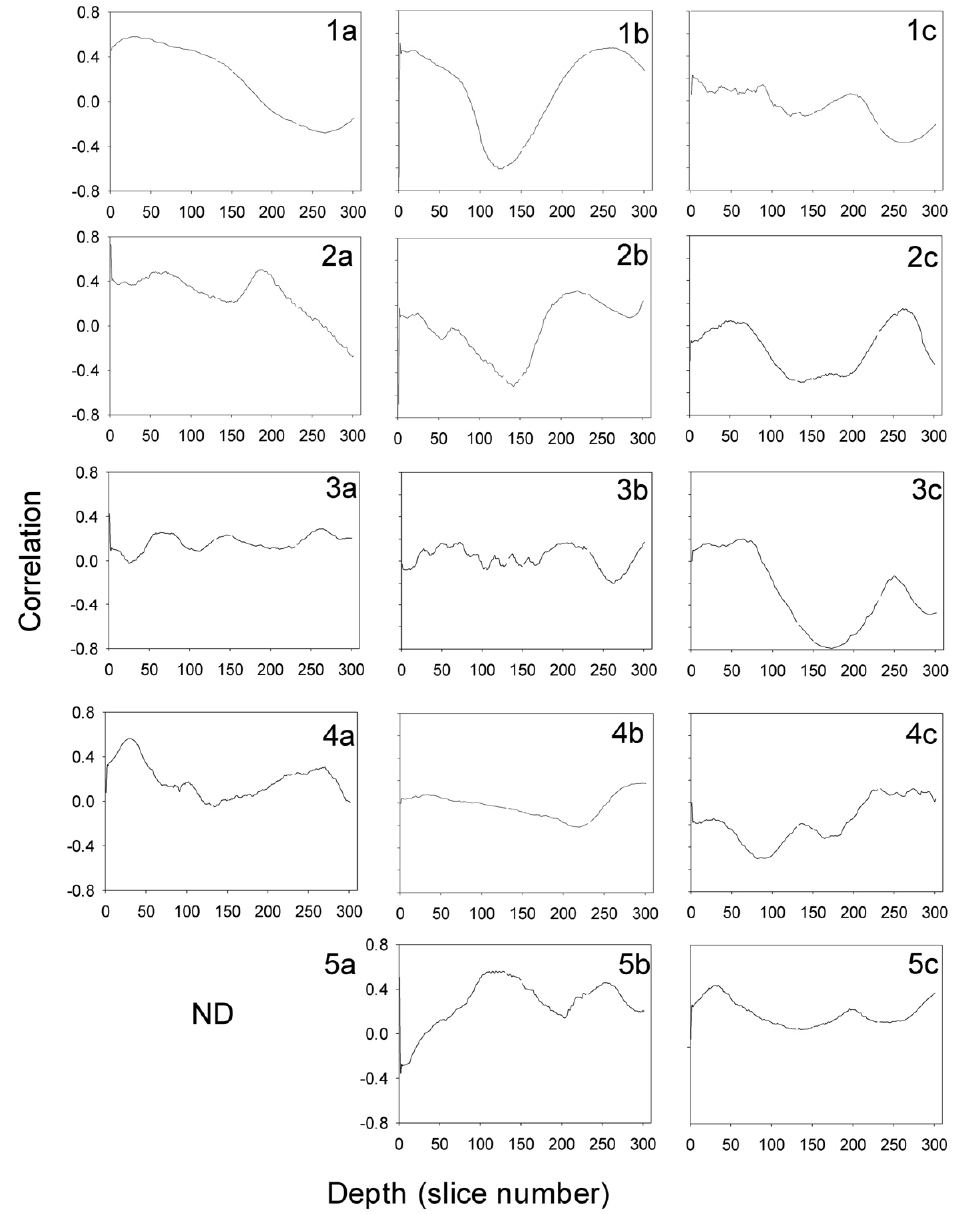
Figure 7. Profiles of the correlation between the X-ray B-scans and the interpolated phased array B − scans from 1 to 300 slices in depth. The first datum is the correlation between the top views of X − ray and PA inspections. Column ( 1 − 5a ) is for the specimens with pores, column ( 1 – 5b ) for slag intrusion and column ( 1 − 5c ) for cracks. ND stands for ‘no